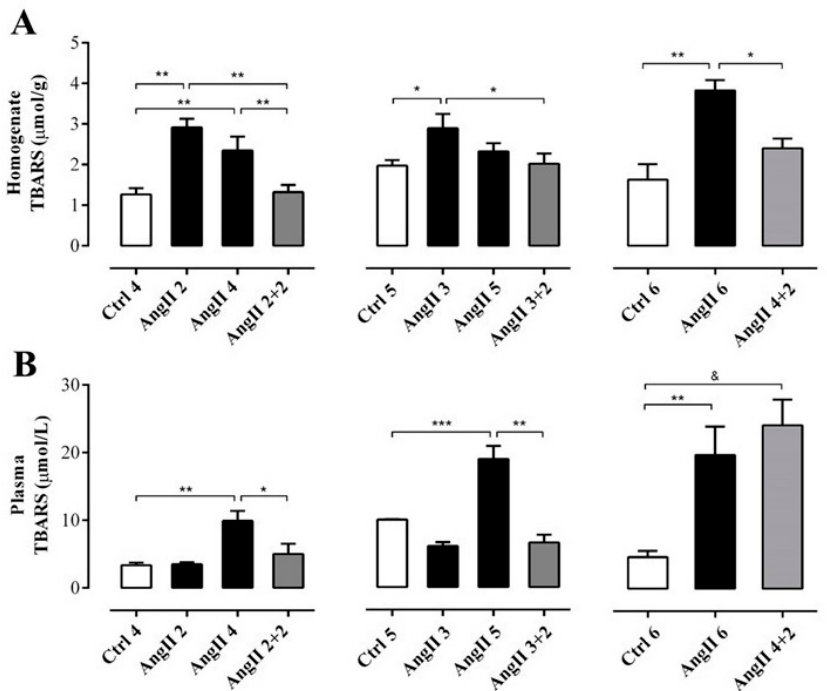
Figure 3. The amount of TBARS remains high in the plasma, but not in the kidney of rats treated with AngII for 4 weeks. Supernatant of kidney homogenates ( A ) and plasma ( B ) were used to measure TBARS as marker of oxidative state. The bars represent the means ± SE of a n ≥ 4 rats per experimental group. The differences between the subgroups of each of the three groups were evaluated by an ANOVA followed by a Tuckey test. *** p < 0.001, ** p <0.01 and * p <0.05 vs. AngII groups; & p < 0.05 vs. AngII 4 + 2.